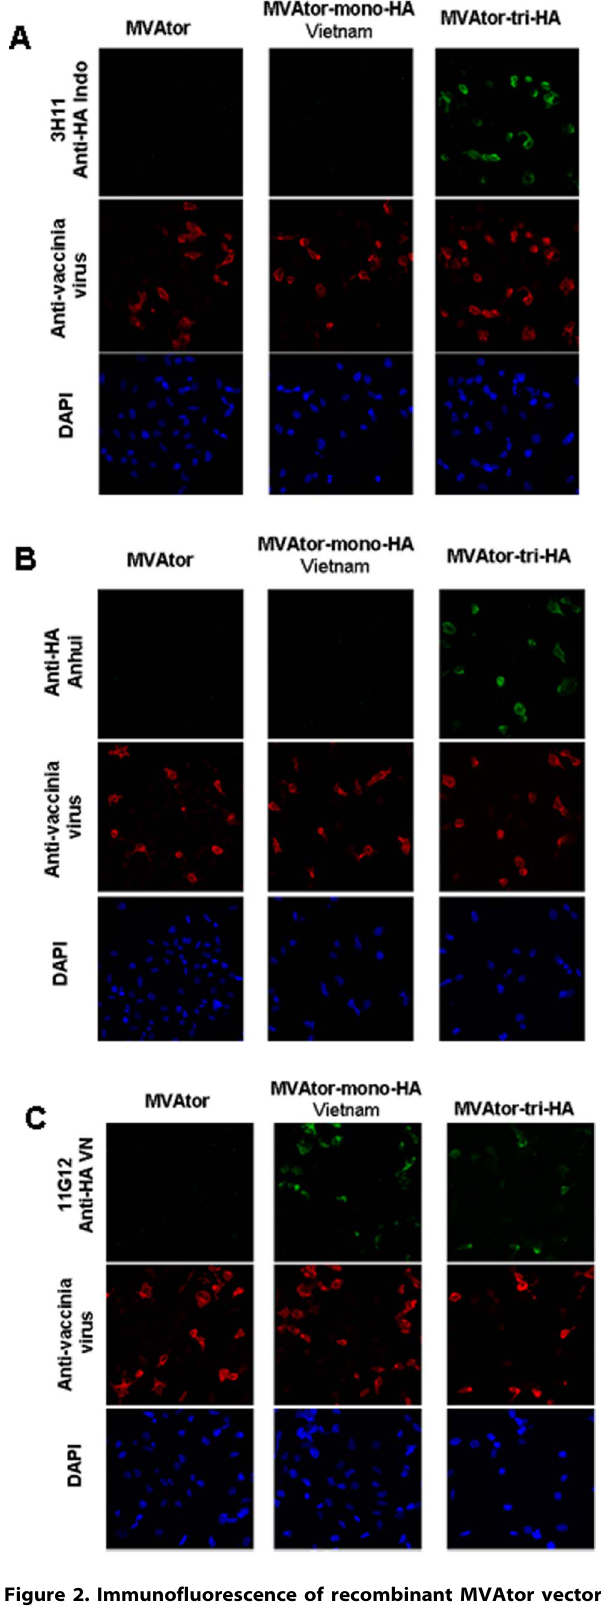
Figure 2. Immunofluorescence of recombinant MVAtor vector infected cells. HeLa cells were infected with MVAtor-mono-HA or MVAtor-tri-HA or MVAtor empty vector respectively and stained with 3H11 mAb specific against A/Indonesia/CDC669/06 (A), AH